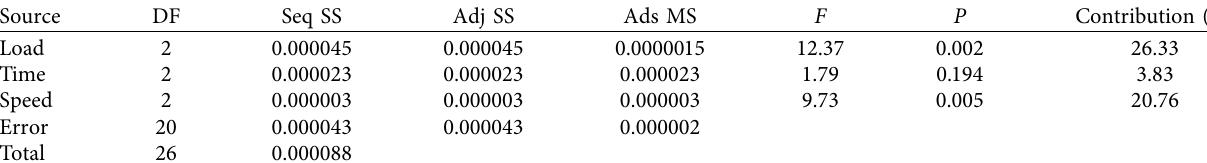
Table 5: Analysis of variance observation.